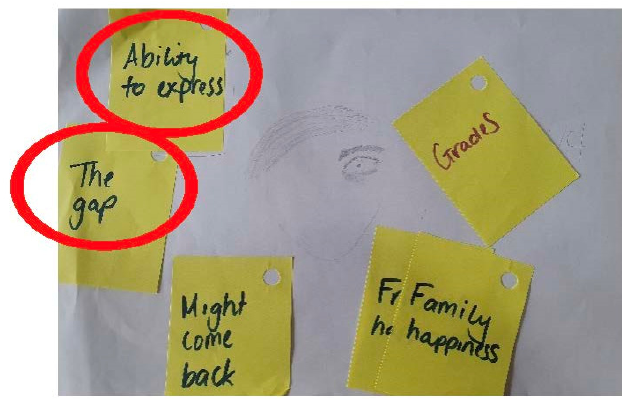
Figure 6. Child’s self-portrait and relative worries (Lucas; male: 12 years) .